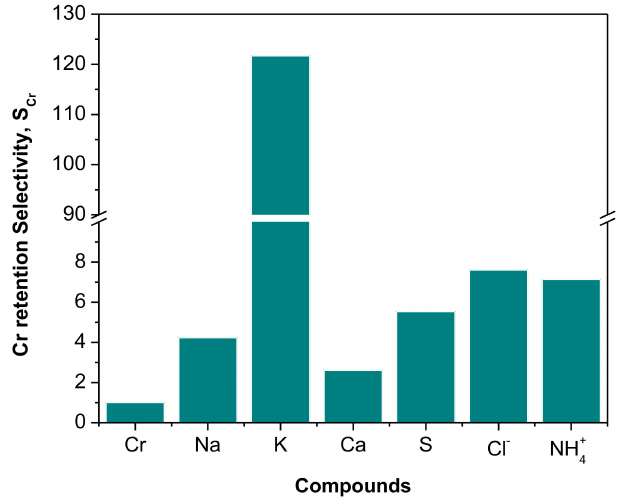
Figure 6. Selective retention of Cr(III), in reference to other species, in the cs-PES MF022 membrane, during diafiltration of the SW30 concentrate of a synthetic tannery effluent at 20 bar.